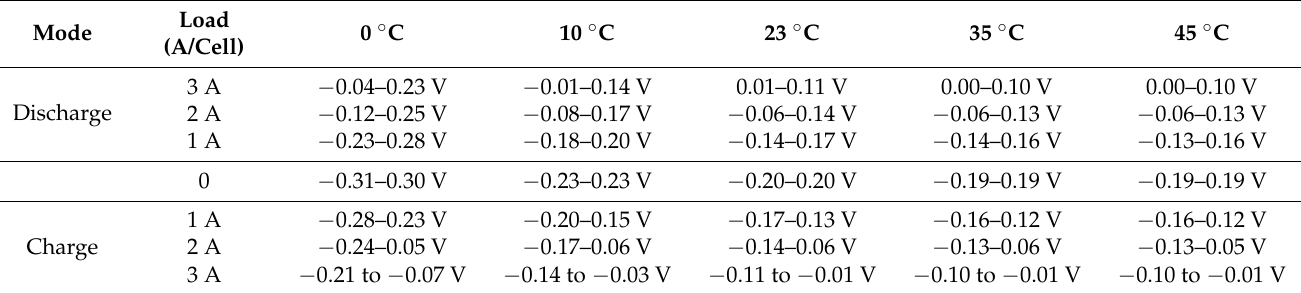
Table 4. Hot swap operating voltage conditions for the 1S4P